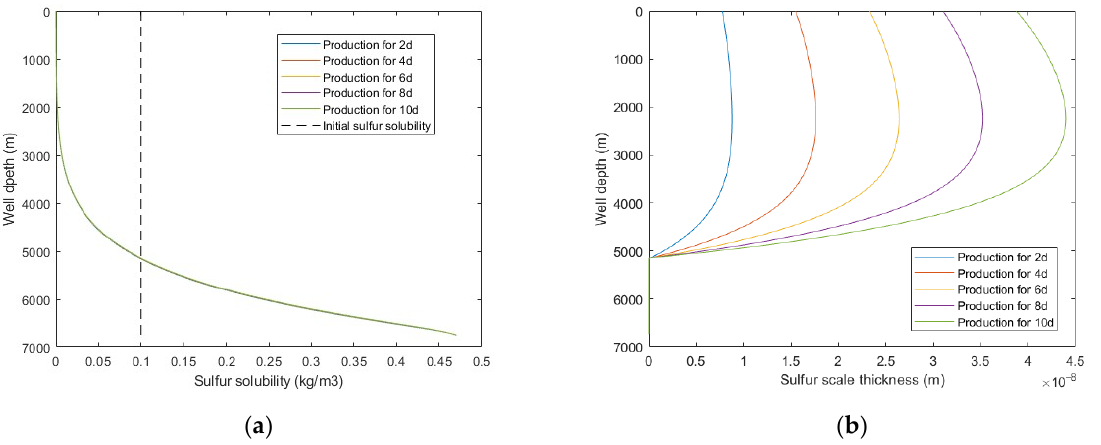
Figure 8. Calculated results with: ( a ) sulfur solubility distribution at different production times; ( b ) sulfur scale thickness distribution at different production times.